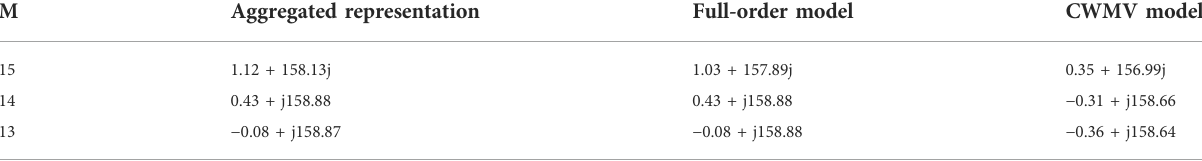
TABLE 7 Torsional oscillation mode of SG 1 when M decreases (case study 4).